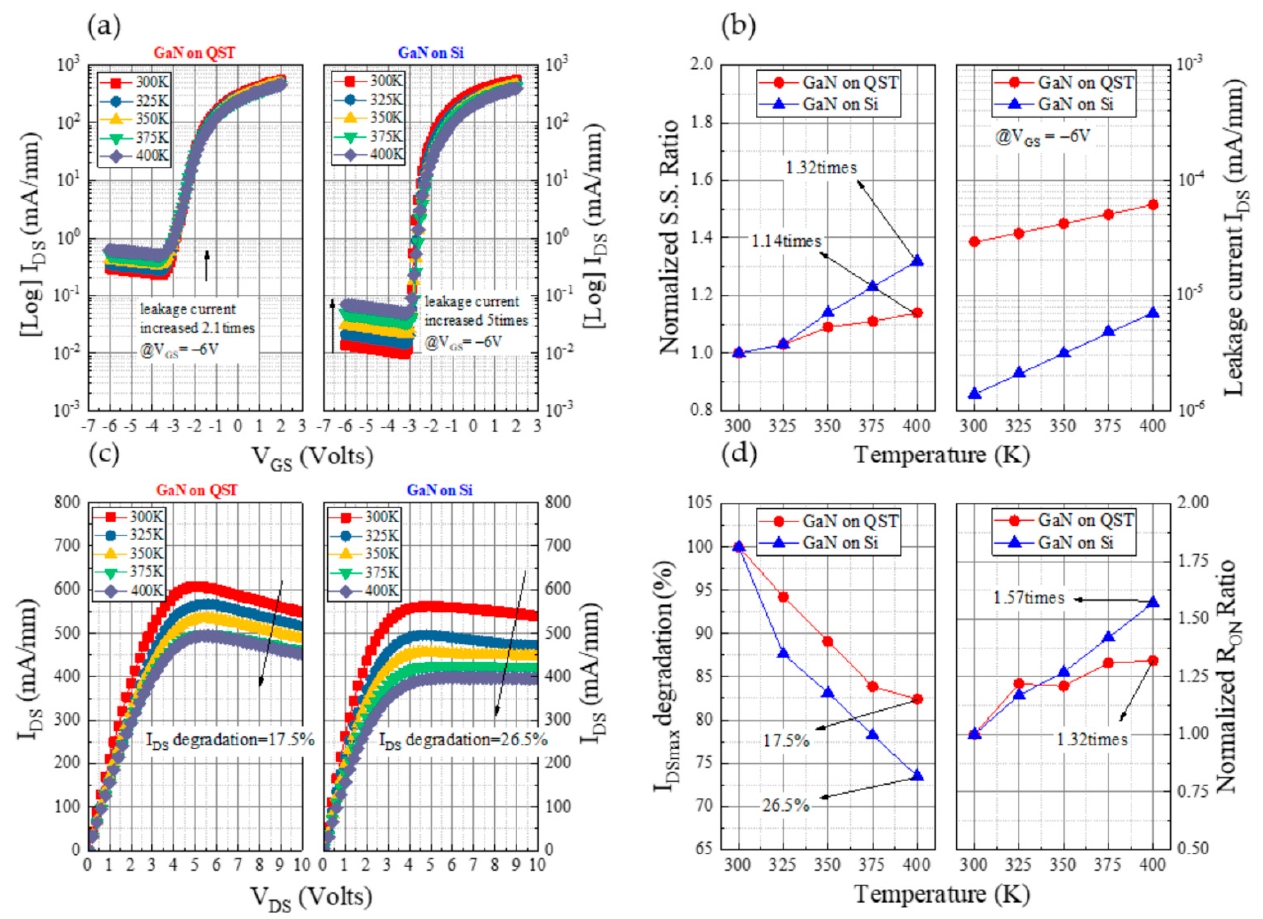
Figure 4. Analysis under various temperatures: ( a ) Transfer characteristics ( I DS – V GS ) for GaN on Si and GaN on QST, ( b ) SS ratio and leakage current at V GS = − 6 V, ( c ) I DS – V DS output current, and ( d ) I DSmax degradation and R ON ratio.